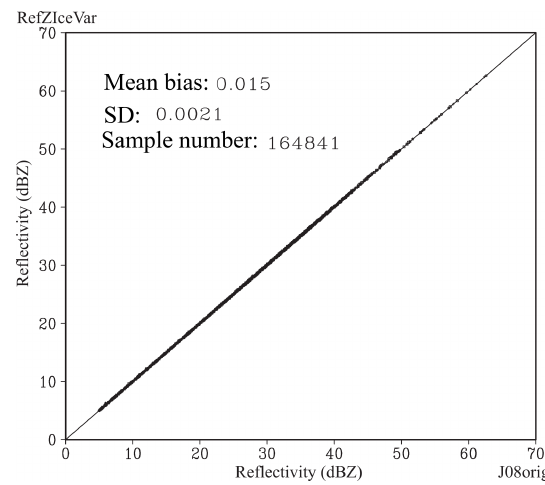
Figure 4. Scatter plot of the reflectivity for J08orig ( x axis) versus RadarVar ( y axis). The bias, standard deviation (SD), and number of samples are listed in the